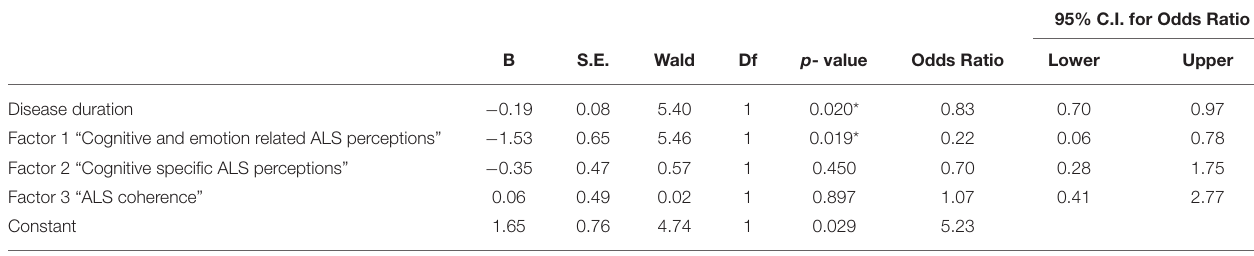
TABLE 4 | Logistic regression predicting likelihood of the presence of behavioural